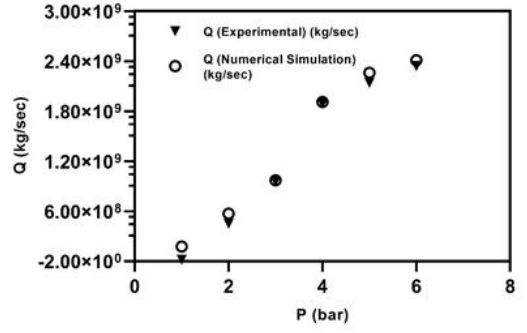
Figure 14: Graph comparing the values of flow rate flowing through the partial open ball valve by numerical simulation and experiment